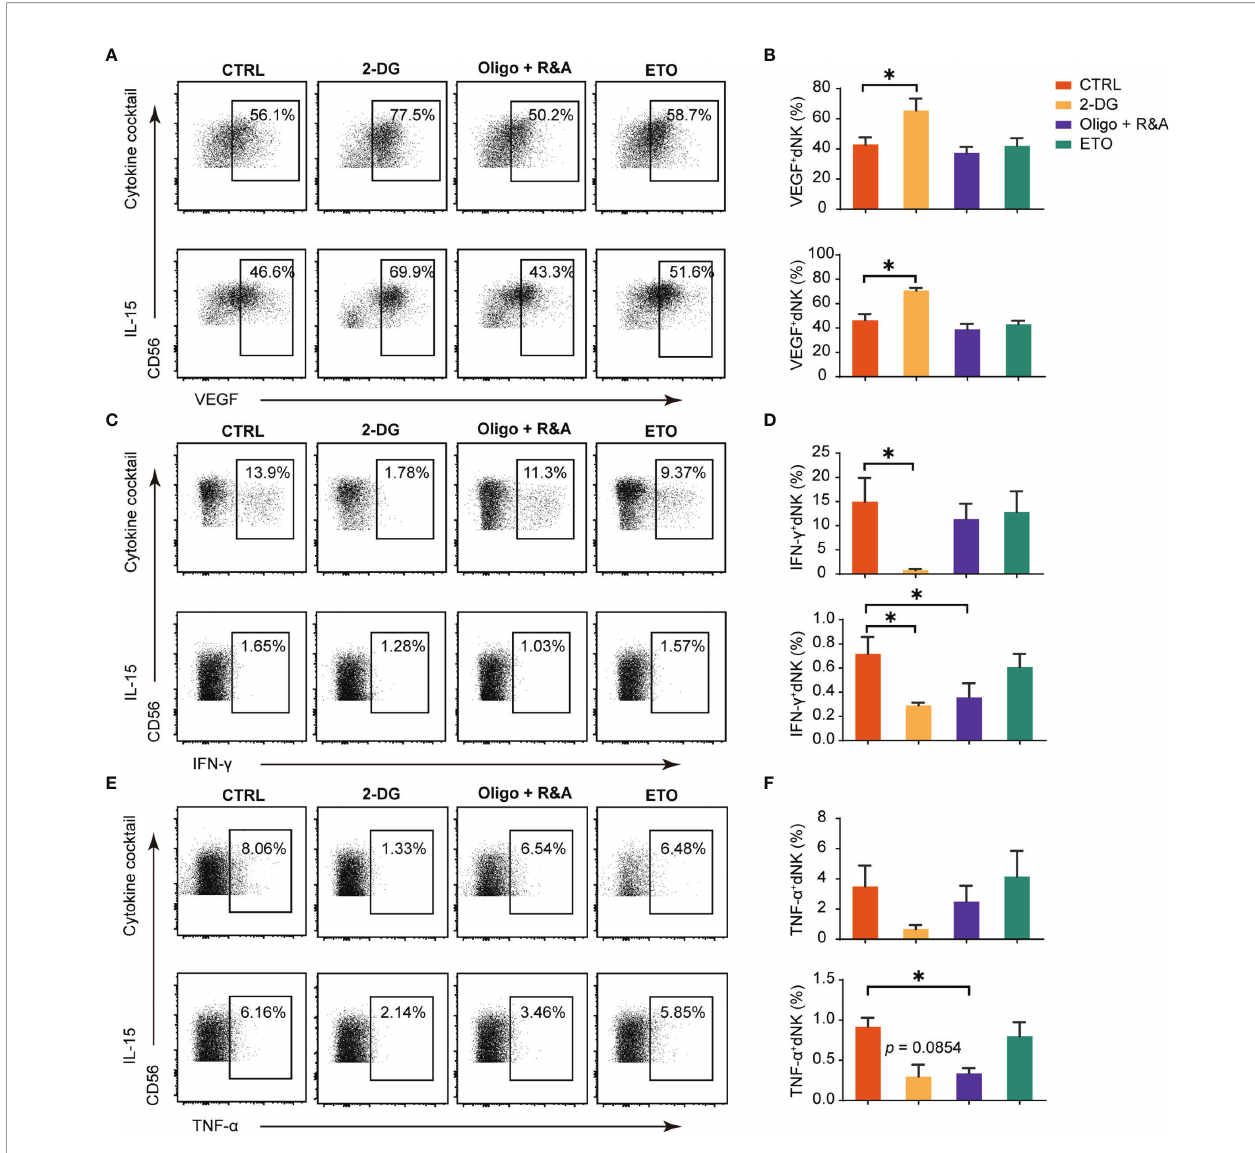
FIGURE 2 | Glucose metabolism as a determinant factor in dNK cytokines production. Representative dot plots of VEGF-A, IFN- g , and TNF- a in decidual NK cells (dNK) (gated as CD45 + CD3 - CD56 + ). Decidual immune cells (DICs) were cultured under the following two conditions (29, 30): (i) IL-15 (20 ng/mL); (ii) a cytokine cocktail (IL-12, 10 ng/ml; IL-15, 10 ng/ml; IL-18, 50 ng/ml);. These cells were cultured added with 2-DG (50 mM) to inhibit glycolysis, oligomycin (1 m M) plus the combination of rotenone (500 nM) and antimycin A (500 nM; Oligo+R&A) to inhibit OXPHOS, and etomoxir (ETO, 10 m M) to inhibit fatty acid oxidation (FAO), respectively. Then, cells were collected for intracellular cytokine staining for VEGF-A (A, B) , IFN- g (C, D) , and TNF- a (E, F) . (n = 5 for all experiments, paired t-test). * P <